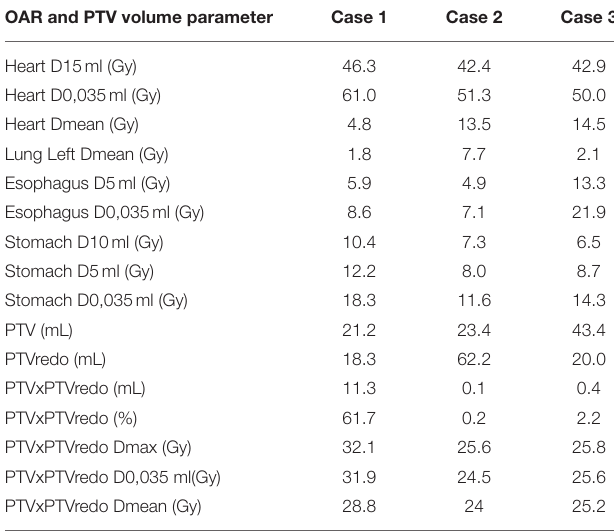
TABLE 2 | Parameters of organs at risk (OAR) and planning target volume